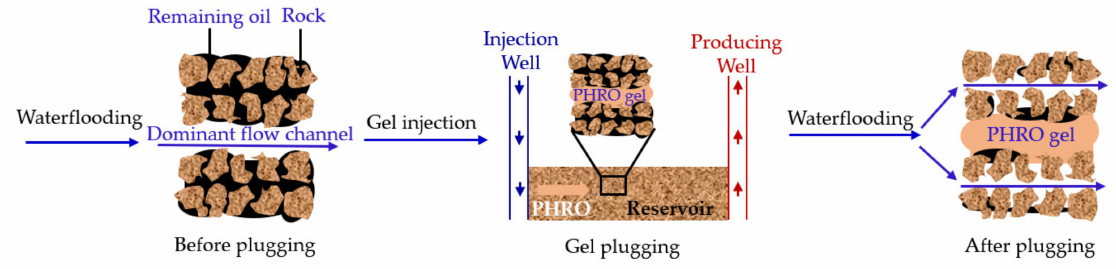
Figure 12. Schematic diagram of functional performance of PHRO gel in formation.